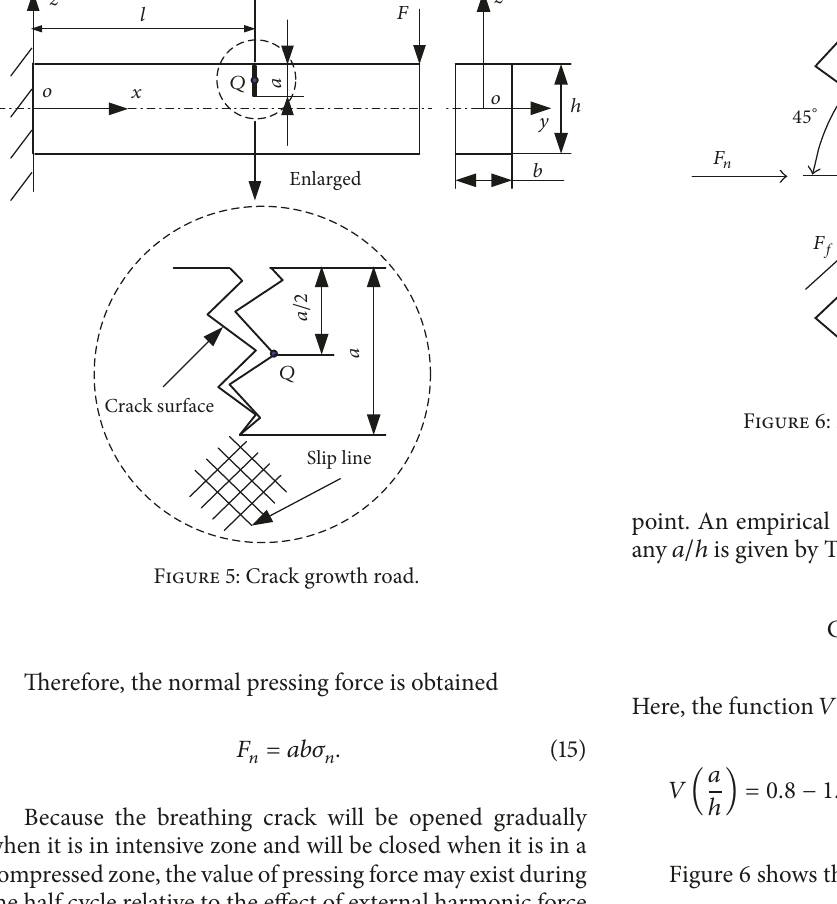
point. An empirical formula for COD with 1% accuracy for any 𝑎/ℎ is given by Tada et al.